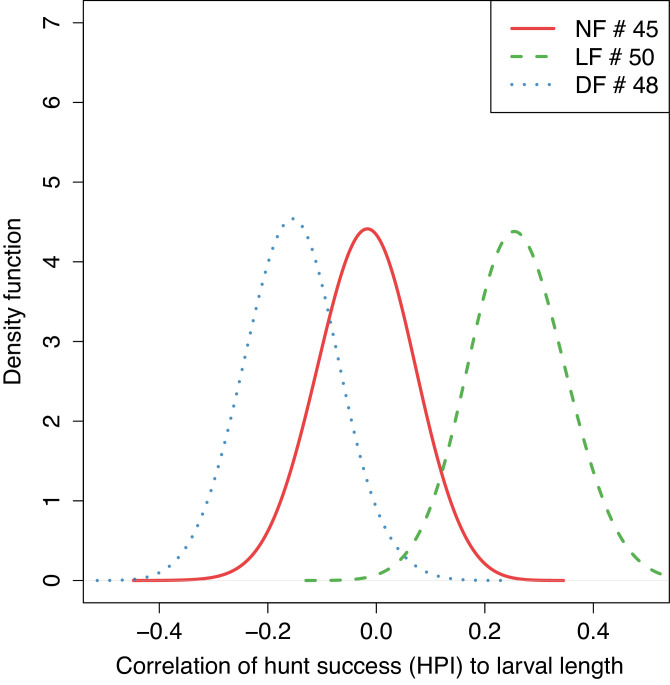
Hunting ability is not explained by larval size.Kernel density estimation of a sampled distribution of Spearman’s correlation coefficients (BW=0.05), obtained by bootstraping 80% of data in each group, shows that larval length does not positively correlate with hunting success in naive larvae (p=1 one-sided t-test for NF and DF), but only in experienced (LF, p<2.2×10-16 one-sided t-test). The fact that a positive correlation only exists for LF suggests a causal relationship by which growth can be impacted by hunting ability, and not vice-versa.